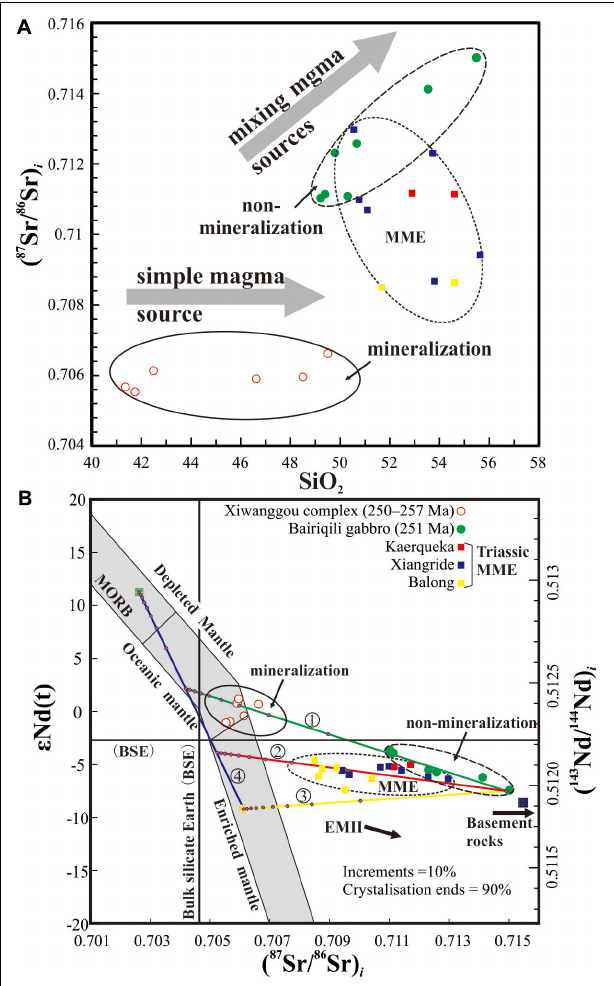
FIGURE 10 | Plots of whole rock ( 87 Sr/ 86 Sr) i vs. SiO 2 (A) and ε Nd( t ) vs. ( 87 Sr/ 86 Sr) i (B) for the Xiwanggou mafic-ultramafic rocks. The depleted and oceanic mantle (plume) plots are from White and Hofmann (1982); the Sr–Nd isotope data for enriched mantle (EM) source from Menzies and Murthy (1980); the values of mafic micro enclaves (MME) hosted in the Triassic granitoid intrusions from are Kaerqueka, Xiangride, and Balong, respectively (Zhang et al., 2012; Xiong et al., 2014; Gao et al., 2015). Comparison data from Xiarihamu for Cu-Ni sulfide mineralized mafic-ultramafic complex (Sun et al., 2014; Li et al., 2015; Song et al., 2016; He et al., 2017; Zhang et al., 2018), and barren mafic-ultramafic intrusions from Bairiqili and Yuejinshan (Xiong et al., 2011b; Liu et al., 2012), in the Eastern Kunlun Orogen. The late Permian mafic-ultramafic rocks show similar evolution trends along mixing line from oceanic mantle to lower crustal materials of basement (cid:192) ; The isotopic components of Triassic MME hosted in the felsic intrusions shows a mixing evolution path (cid:193) that lies between a lithospheric mantle source magma and a partial melting of lower crust source (Gao et al., 2015); Evolution path (cid:194) starts at EM with elevating ( 87 Sr/ 86 Sr) i values, which is a trend similar to the EMII; Mixing line (cid:195) shows an initial mantle evolution from a depleted to an enriched mantle.